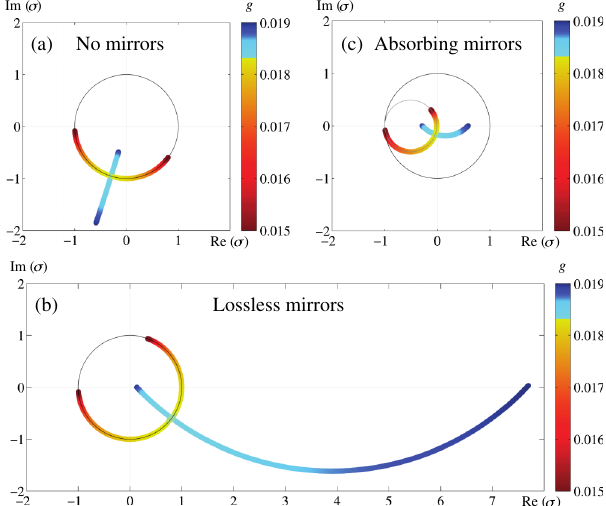
FIG. 3. Movement of the scattering-matrix eigenvalues (cid:1) for i the PT -scattering system shown in Fig. 1(a) as a function of the gain-loss strength g (see the color bars on the right-hand sides of the panels) and at k ¼ 515 : 0 . (a) The case without externally move on the unit circle and placed mirrors where two (cid:1) i coincide at a critical value of g (see the color bar on the side). (b) Placing thin dielectric mirrors symmetrically around the on the unit circle (below thresh- gain-loss region rotates the (cid:1) i old) but leaves the critical gain-loss strength at which they coalesce invariant. (c) We have added the same degree of absorption to both mirrors, which shrinks the circle on which rotate (below threshold) to a smaller circle that touches the (cid:1) i the unit circle at (cid:1) ¼ (cid:2) 1 and that has its center on the real axis. Also, in this case, the critical gain-loss strength at which the two (cid:1) coalesce is the same as in (a) and i